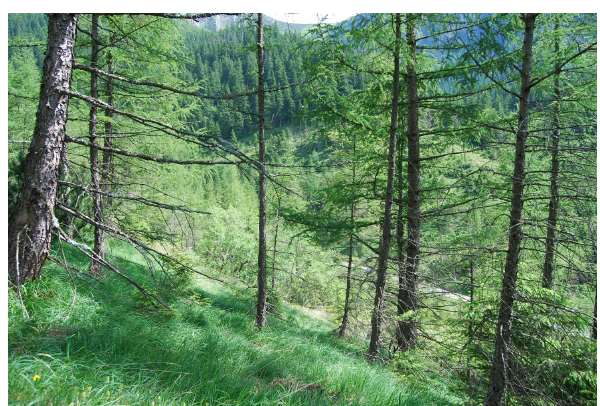
Figure 4. Open larch ( Larix sp.) forest with a dense cover of grass Calamagrostis sp. on the forest floor – plot no.